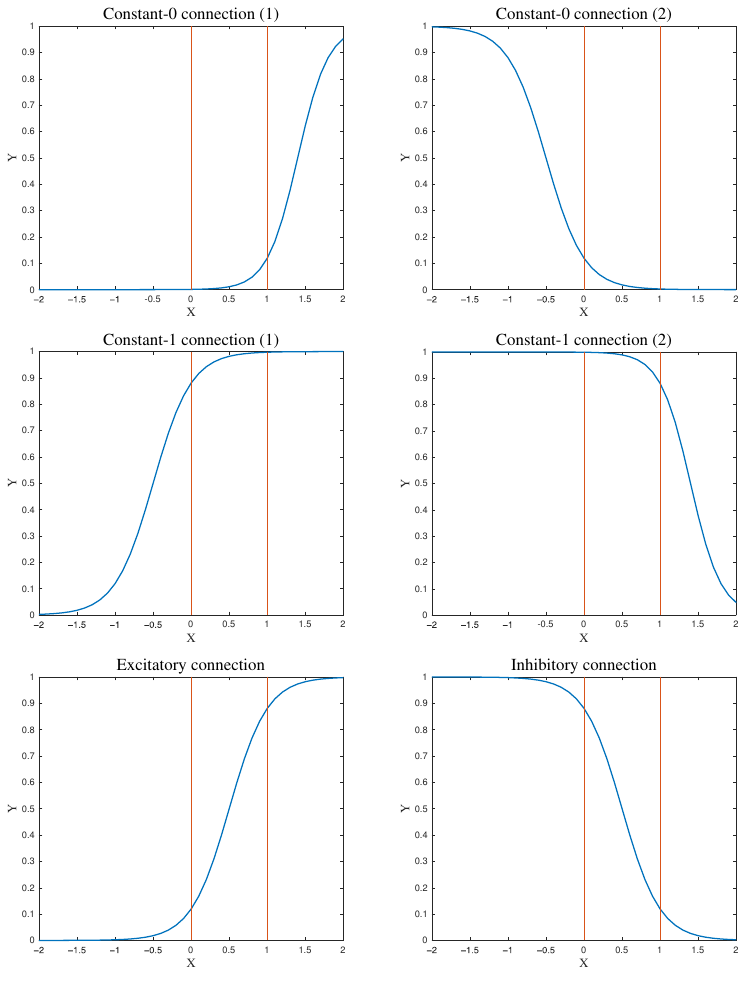
Figure 3. Connection cases of the synaptic